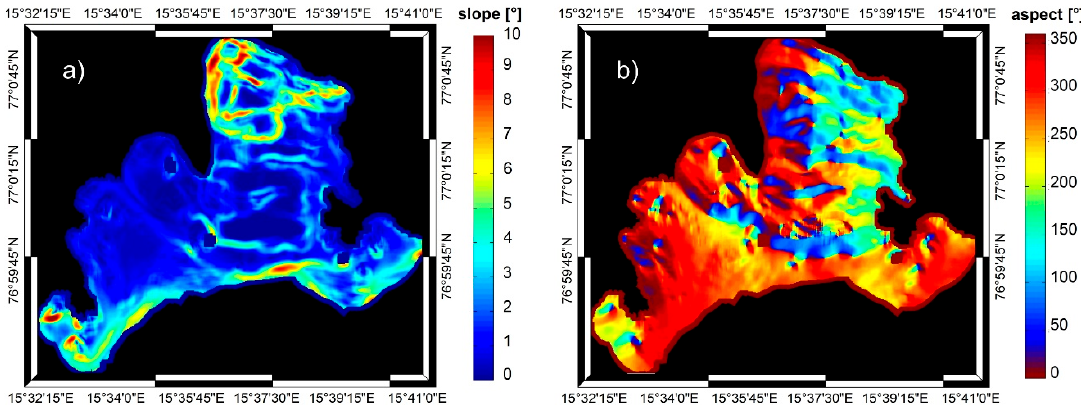
Figure 2. ( a ) Slope of the seafloor; ( b ) aspect of the bay’s seafloor, parameters calculated in a moving window of 70 × 70 m dimensions and overlapping by 90%.